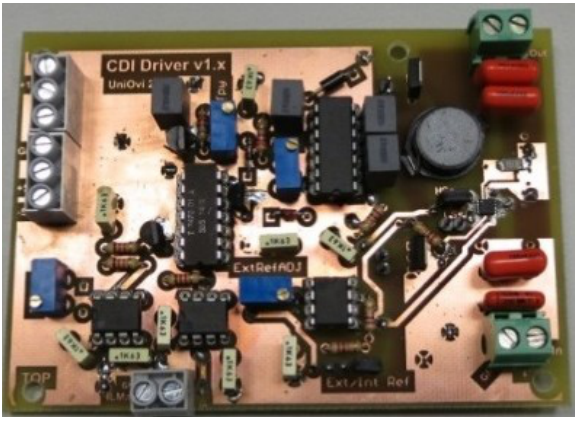
Figure 9. Buck-boost